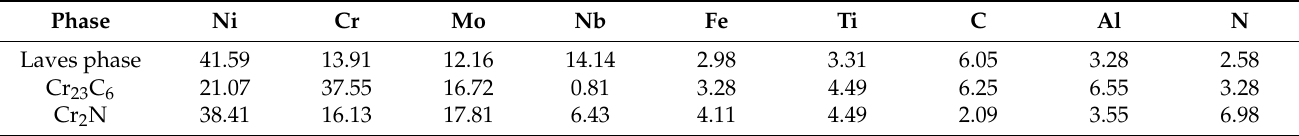
Table 3. The chemical composition of the precipitated phase of weld cladding (at %).